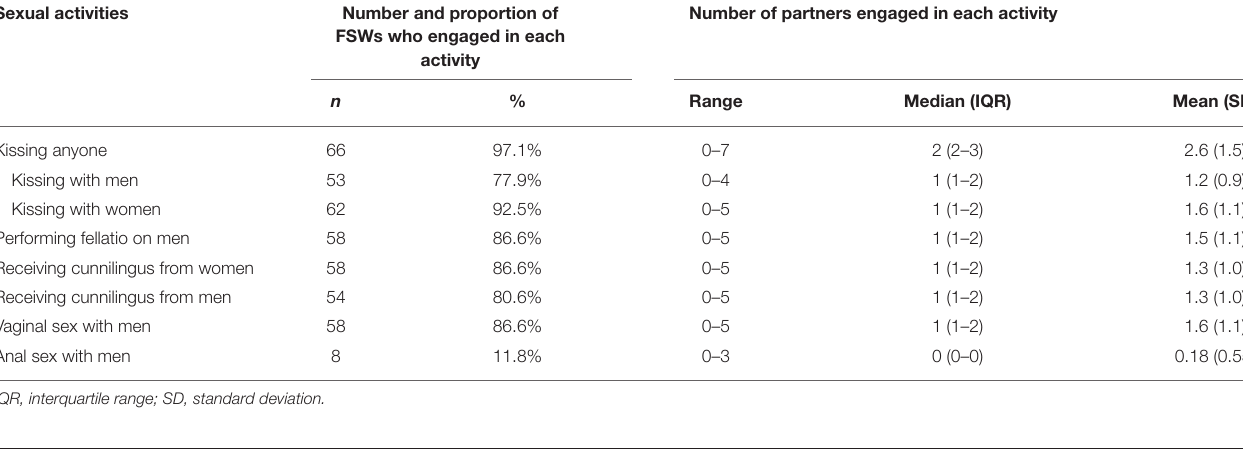
TABLE 3 | Different types of sexual activities involved in the most recent group sex among 68 female sex